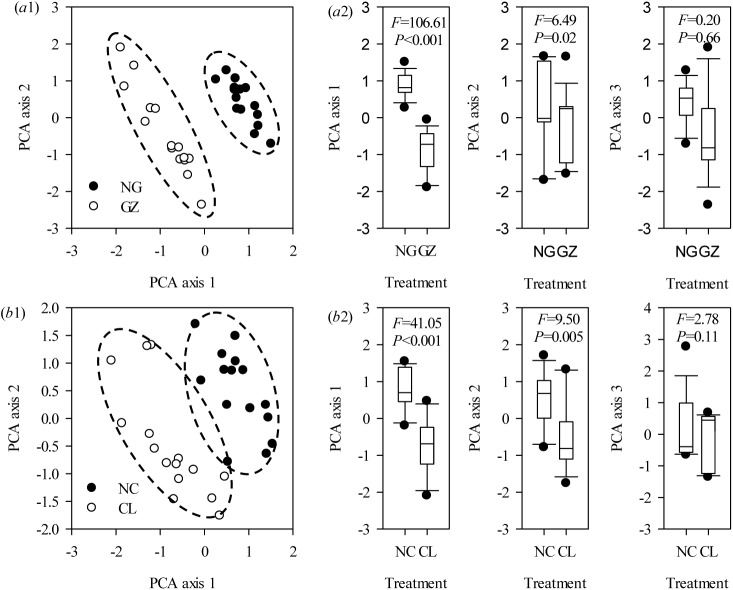
PCA bi-plot of Leymus chinensis (Trin.) Tzvelev functional traits for long-term grazing and clipping field treatments based on the variance in 10 functional traits explained by the first (PCA 1), second (PCA 2), and third (PCA 3) principal axes.(a1) and (b1): PCA ordination of Leymus chinensis (Trin.) Tzvelev plants from ungrazed or unclipped (solid circle) and grazed or clipped (empty circle) conditions in field and hydroponic experiments, respectively. (a2) and (b2): Box plots illustrate the score distribution of Leymus chinensis (Trin.) Tzvelev functional traits for plants from different communities along the three principal axes. Abbreviations: NC, unclipped; CL, clipped; NG, ungrazed; GZ, grazed.